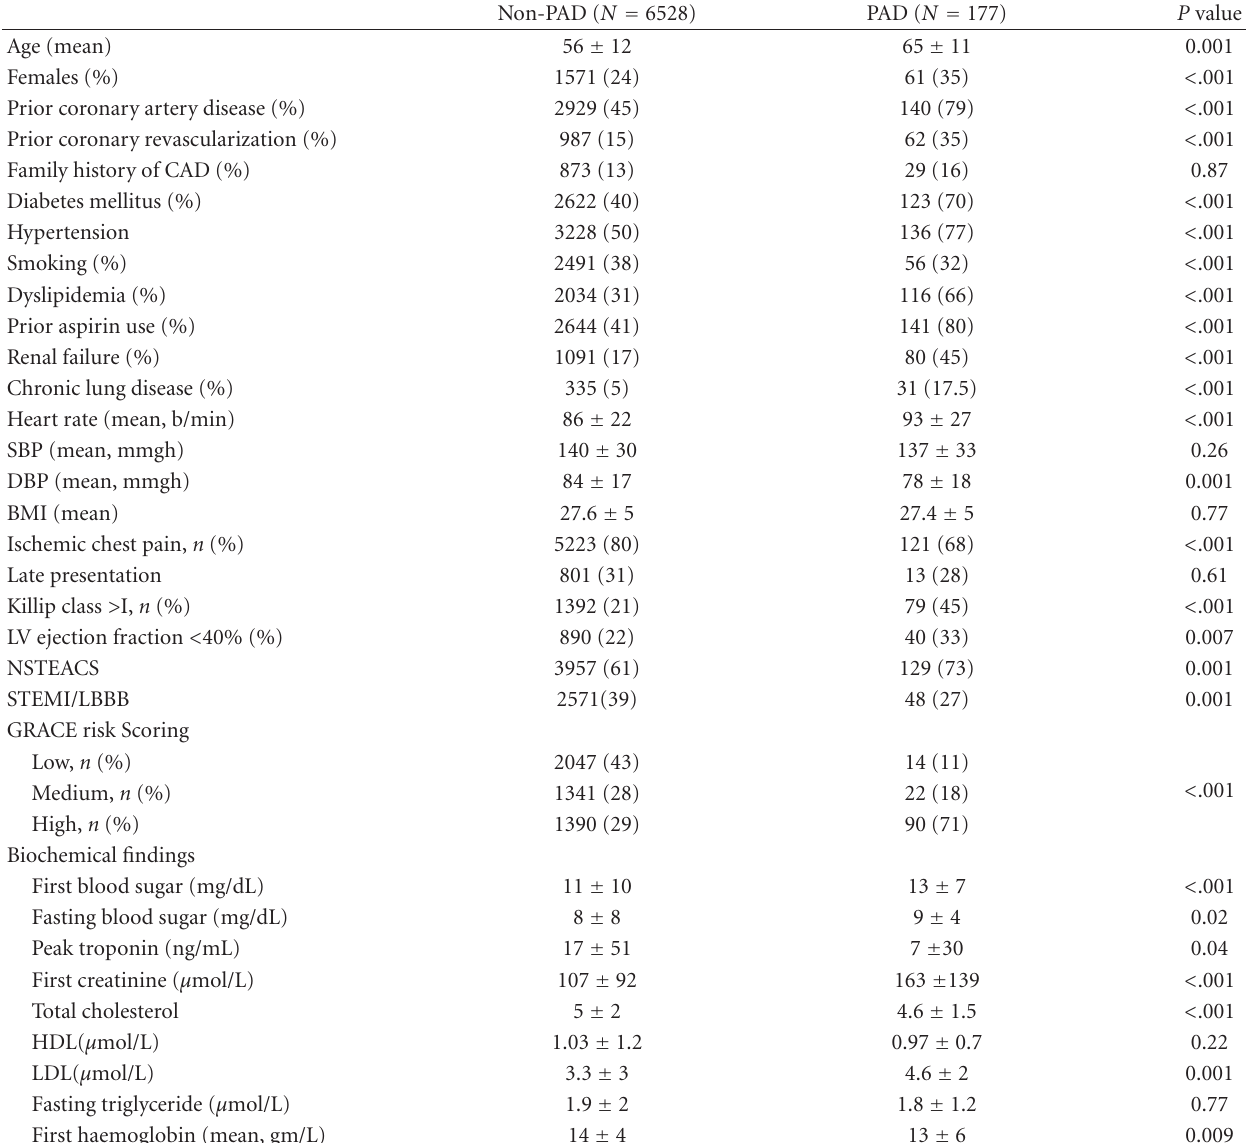
Table 1: Clinical and biochemical profiles of patients with acute coronary